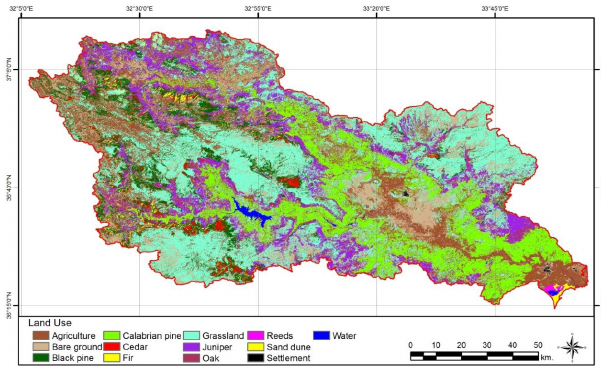
Figure 2. Land Cover Map of Goksu Watershed used a an input in CASA Model.